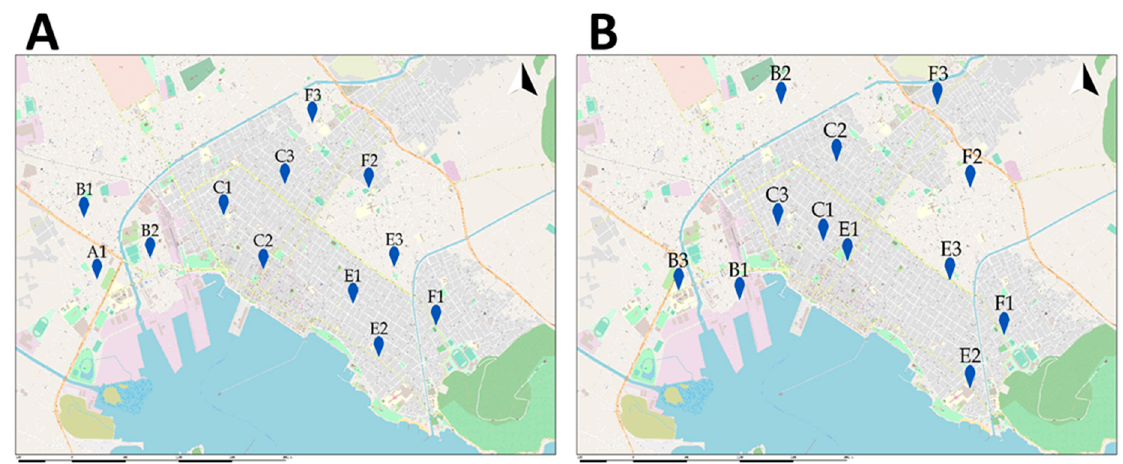
Figure 4. The optimal sensor placement according to the mathematical model (twelve sensors) ( A ) and the actual placement of sensors (twelve sensors) ( B ).